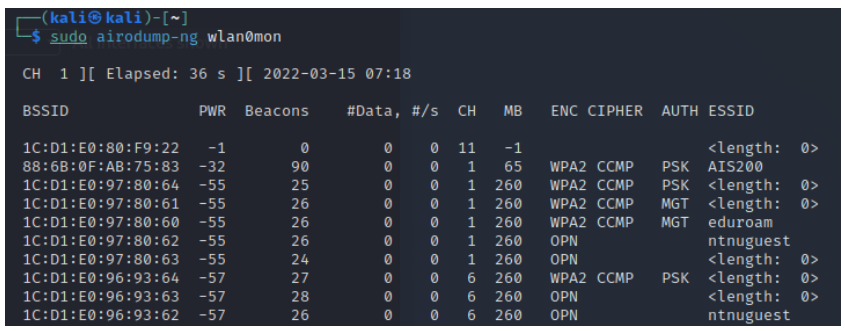
Figure 3. Airodump-ng running in